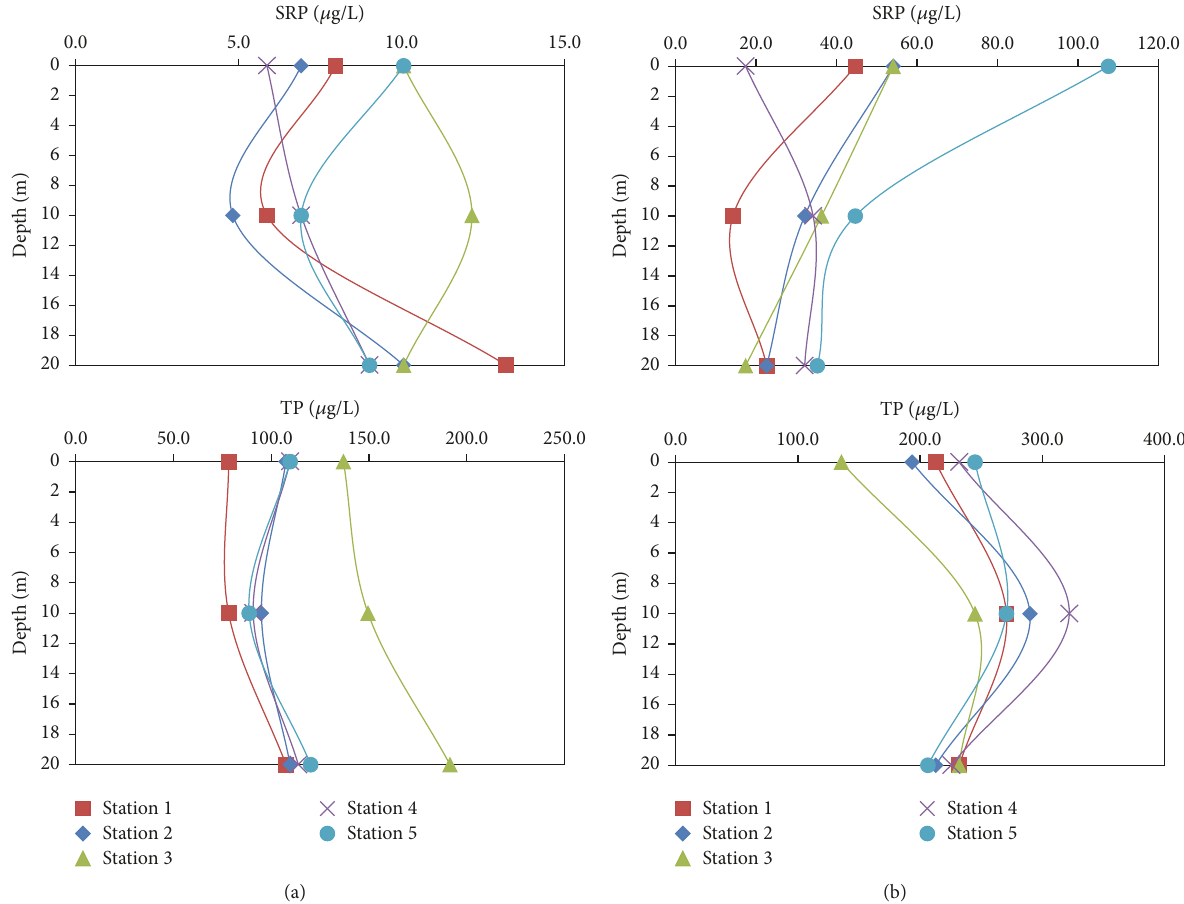
Figure 6: The distribution of SRP and TP at three different depths (0, 10, and 20 m) of Bakun Reservoir in February (a) and September (b) 2014.